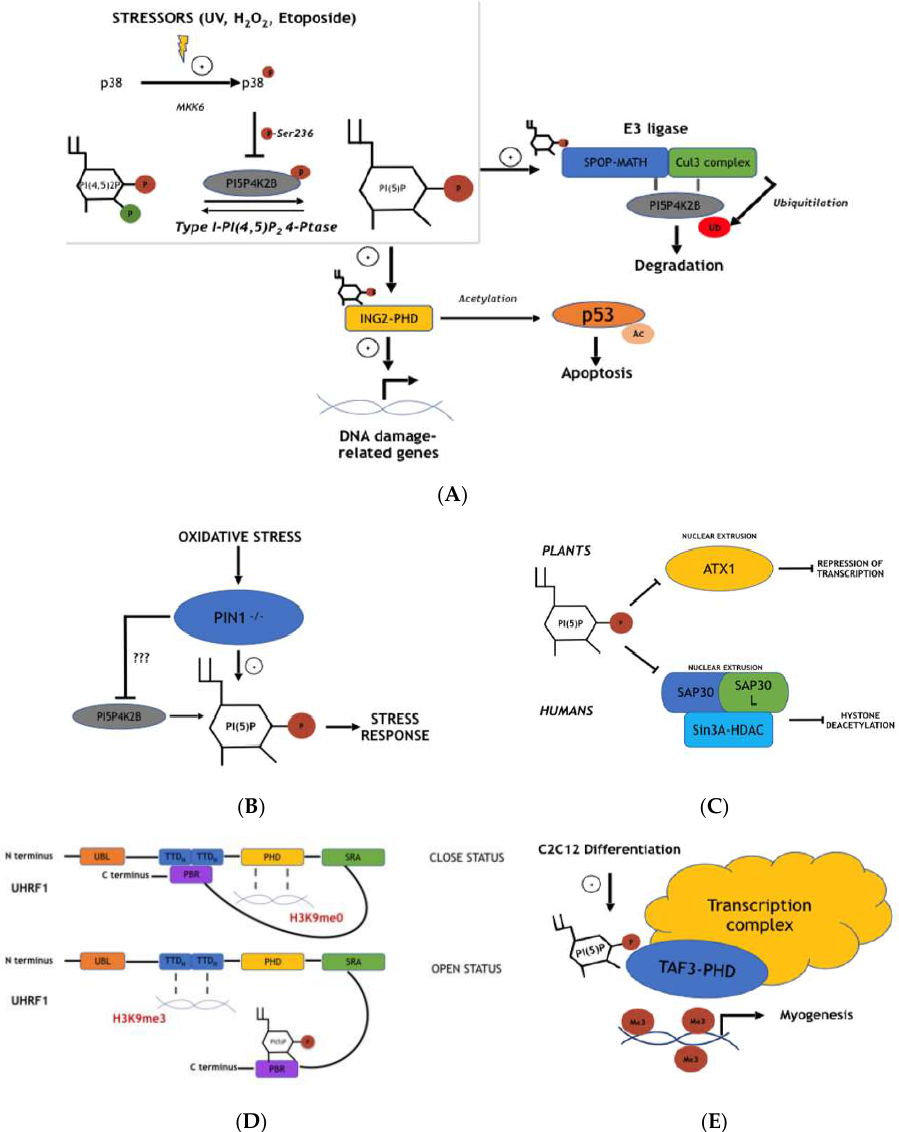
Figure 2. The role of PI5P in nuclear outputs and PI5P as lipid second messenger involved in different nuclear functions. ( A ) Increased levels of PI5P during cellular stress affect ING2 and cellular responses through PIP4K2B and type I PI(4,5)P 2 4-ptase activity. Moreover, PI5P can modulate Cul3 E3 ligase/substrate-specific adaptor protein (SPOP) binding, leading to PI5P4K2B/PIP4K2B degradation. ( B ) Pin1 regulates PI5P upon oxidative stress. ( C ) ATX1 and SAP30/SAP30L are extruded from the cell nucleus by PI5P binding. ( D ) Uhrf1 conformation and binding capacity of either H3K9me3 or H3K9me0 DNA regions is mediated by interaction with PI5P. ( E ) TAF3-mediated regulation of genes involved in myogenic differentiation requires PI5P.